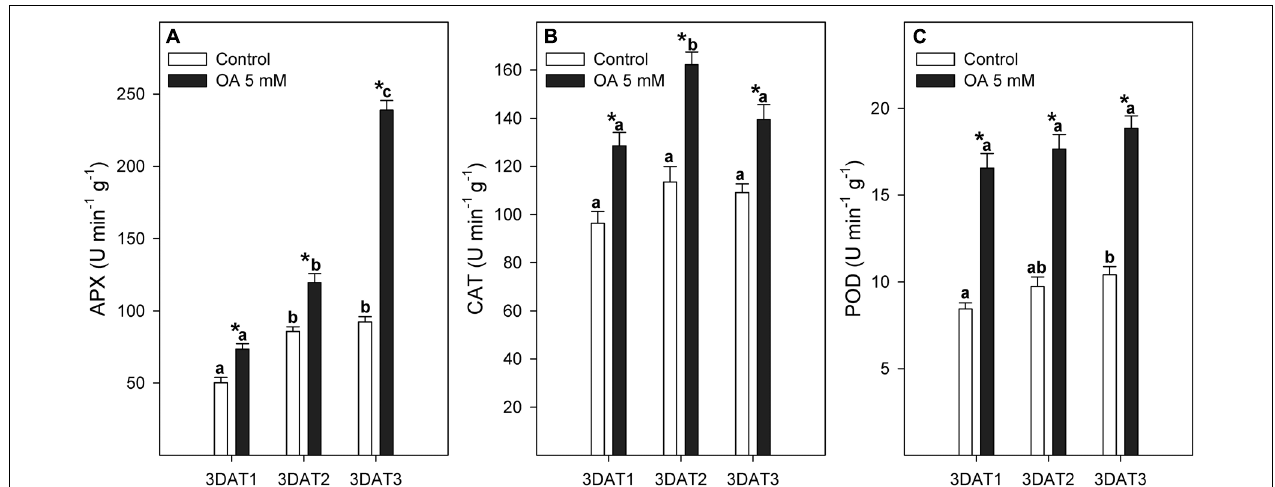
FIGURE 2 | Evolution of APX (A) , CAT (B) , and POD (C) activities (U min − 1 g − 1 ) measured in control and 5 mM oxalic acid (OA)-treated ‘Magenta’ table grapes during three key growth and ripening stages in preharvest: 3DAT1 (3 days after the first treatment when berries reached ca. 40% of its final size), 3ADT2 (3 days after the second treatment when veraison stage started), and 3DAT3 (3 days after the third treatment, at harvest). Data are the mean ± SE. Significant differences ( p < 0.05 according to Student’s t -test) between control and OA-treated berries were expressed as * symbol placed in the OA bar for each stage and parameter. Different lowercase letters show significant differences ( p < 0.05 according to HSD Duncan’s test) among the three stages during berry development.